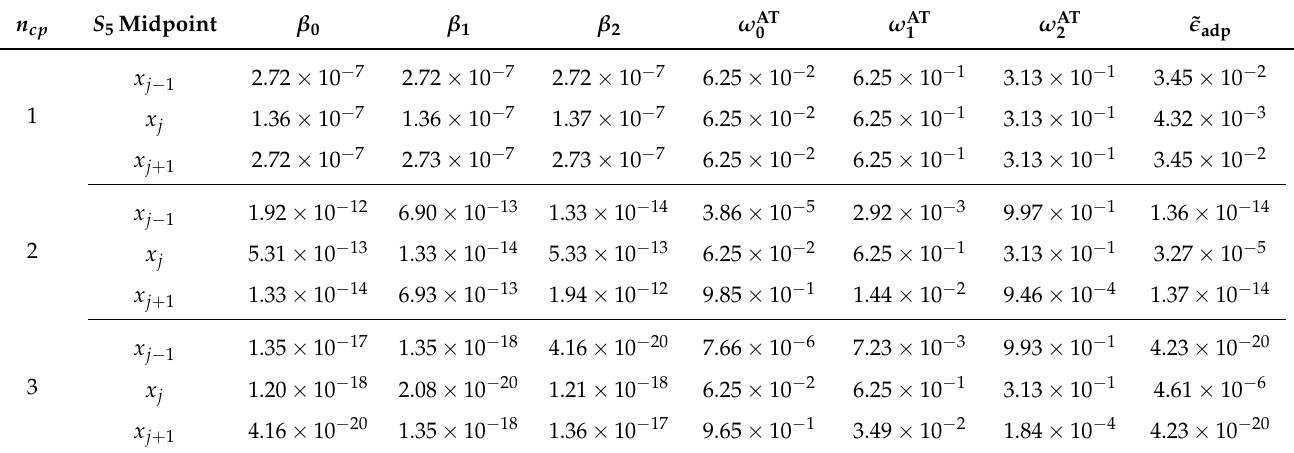
Table 2. The β k , ω AT , and ˜ (cid:101) adp ( p = 2,4,6 ) of g n ( x )( n = 2,3,4 ) near x j = 0 for k